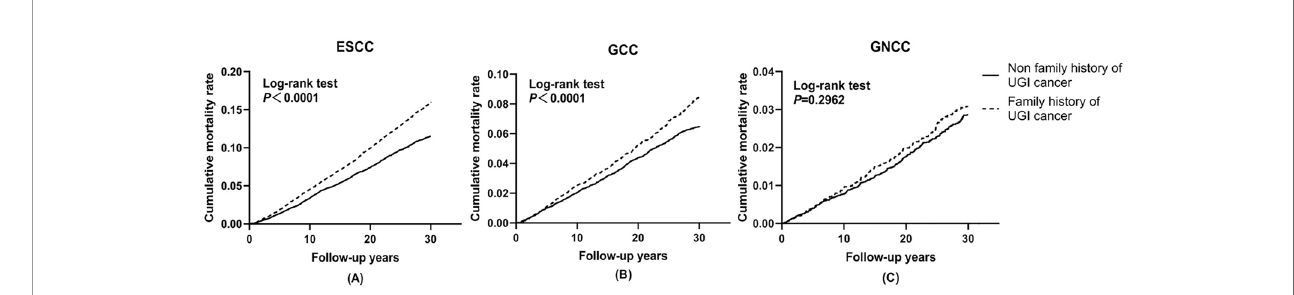
FIGURE 2 | Effect of family history of UGI cancer on cumulative mortality caused by ESCC (A) , GCC (B) , and GNCC (C) . ESCC, esophageal squamous cell carcinoma; GCC, gastric cardia carcinoma; GNCC, gastric